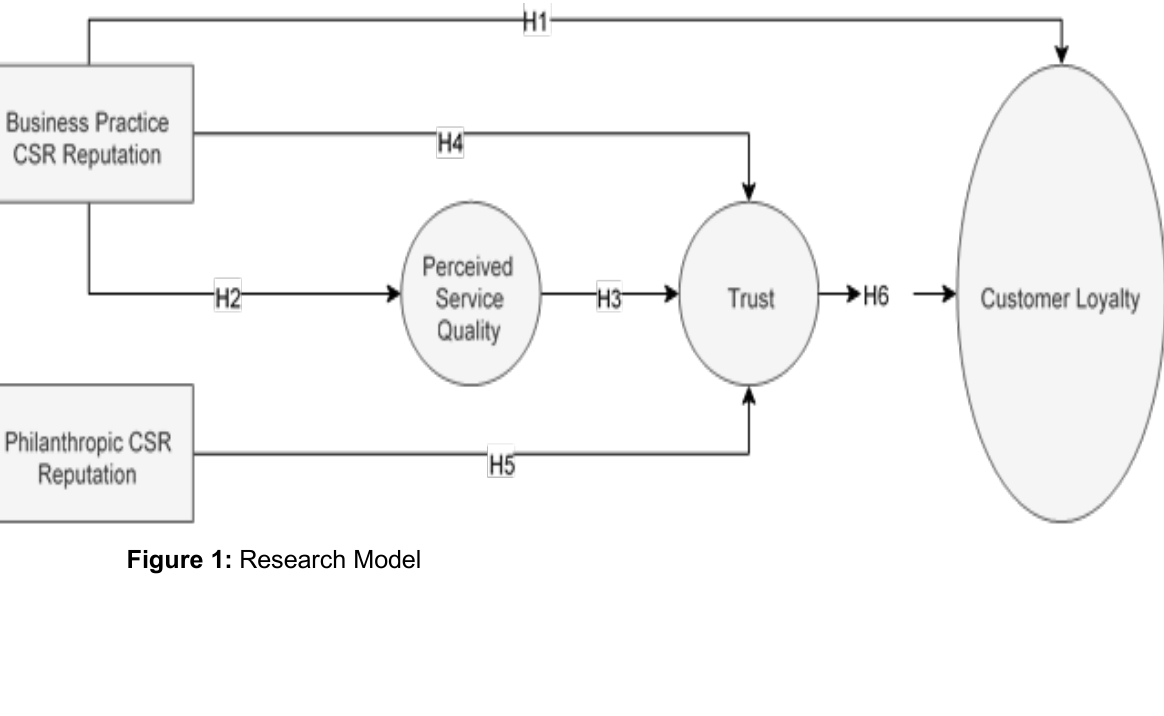
Figure 1: Research